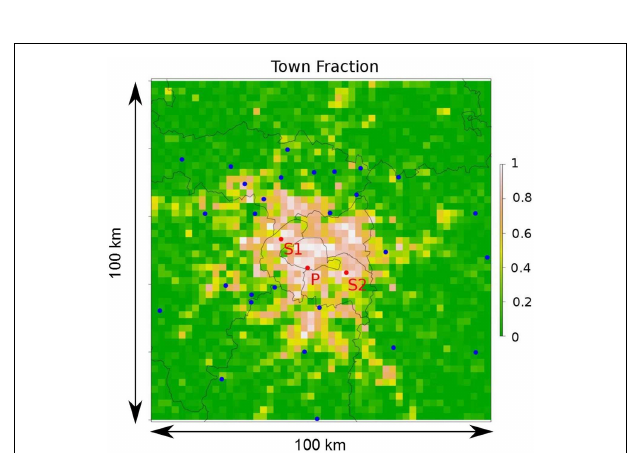
FIGURE 9 | Comparison of the UHI at 2 m in Paris on the 29th of May computed by the SUWG with an average of data files from four different airports around Paris and a full atmospheric model MesoNH simulation.